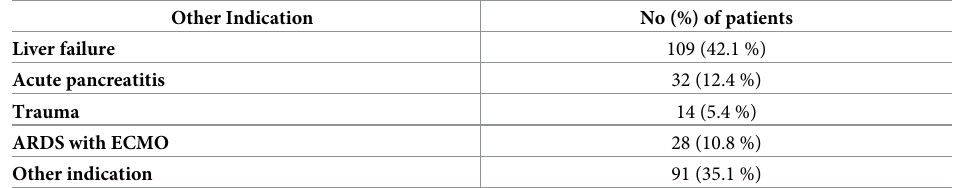
Table 4. Indications other than sepsis and cardiac